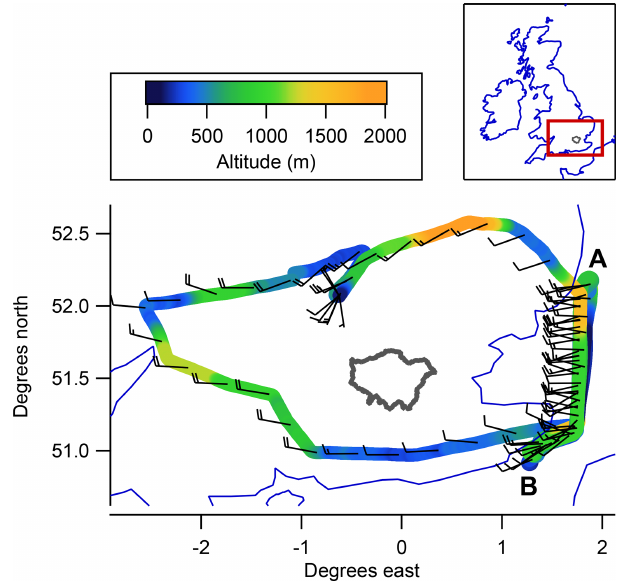
Figure 1. Aircraft flight track on 4 March 2016, coloured by alti- tude. Wind barbs are used to represent wind speed and direction, av- eraged over 5min, using the convention where each full wind barb represents a wind speed of 10kn. The border of the Greater London administrative region is shown in grey for